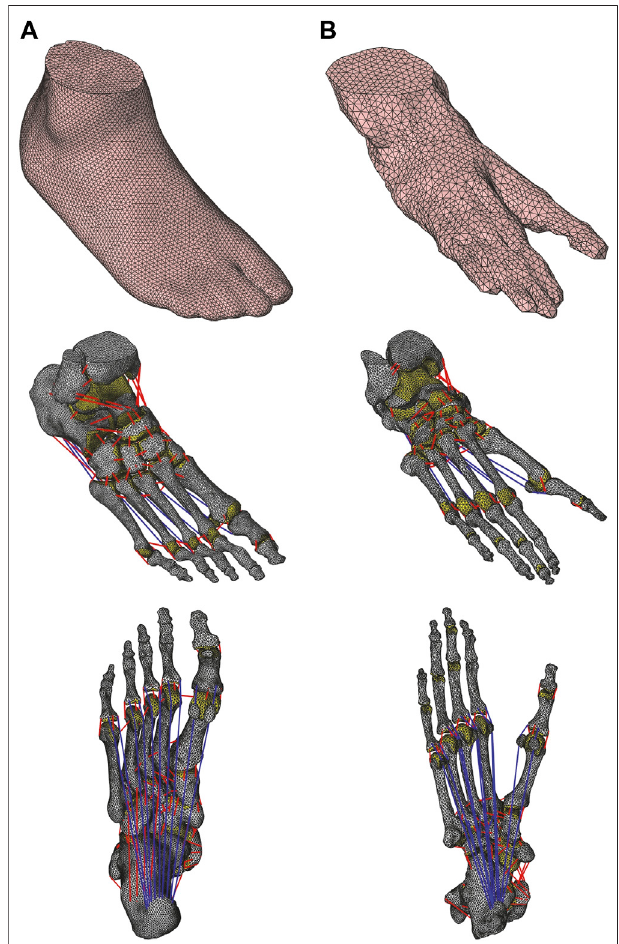
FIGURE1| Finiteelementmodelsofhuman (A) andchimpanzeefoot (B) with and without soft tissue. Plantar view of foot models show plantar aponeurosis. Cartilages are illustrated as yellow areas; ligaments and plantar aponeurosis are indicated by red and blue lines,